Question: Produce a descriptive caption suitable for publication.
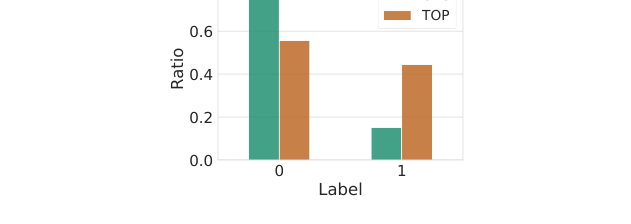
Answer: A plot of the distributions of the data Shapley values as well as the label ratio of 3 datasets. Note that to simplify the setup, we use the simple baseline features of the patients and their clinical discharge notes as the external datasets to obtain Shapley values and pseudolabels.